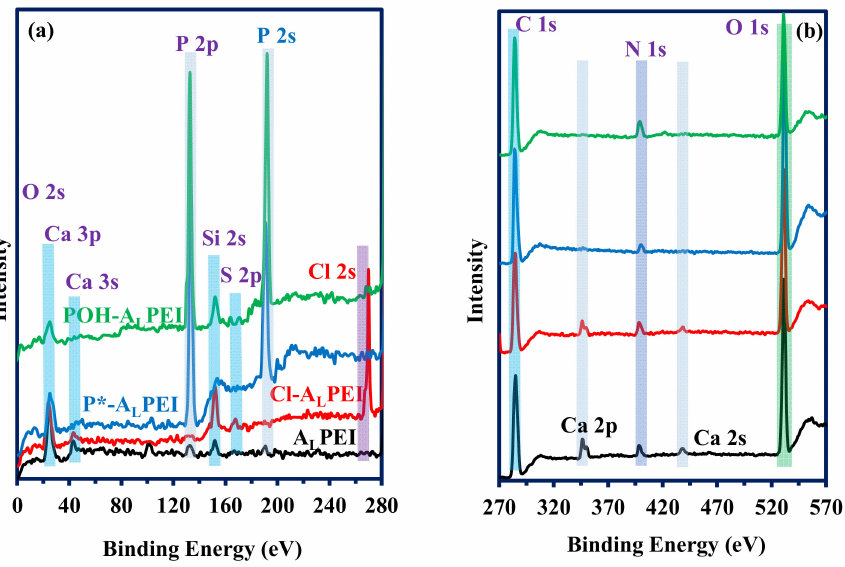
Figure 3. XPS survey spectra of A L PEI beads, intermediary products (epichlorohydrin-activated